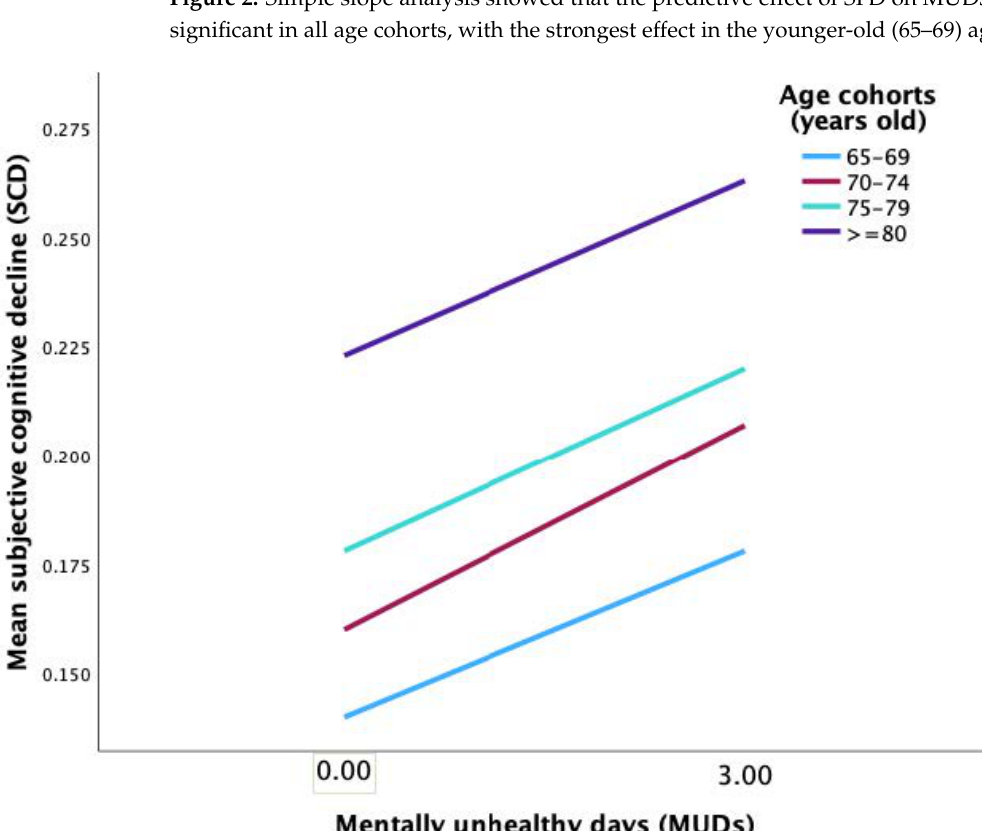
Figure 3. Simple slope analysis showed that the predictive effect of mentally unhealthy days on the SCD was not statistically significant at each level of the age cohorts.